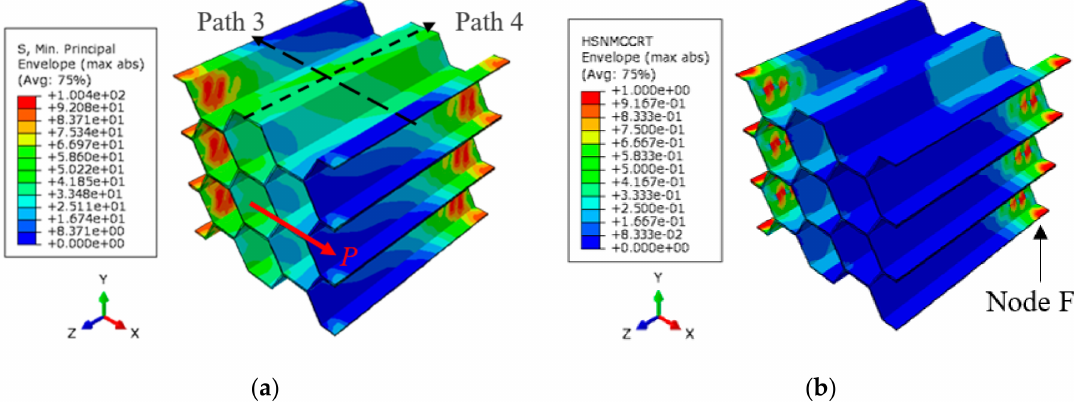
Figure 19. ( a ) Minimum principal (compressive) stress at failure, and ( b ) the corresponding compressive matrix damage of the HC core model, at the end of the shear test, in the ribbon